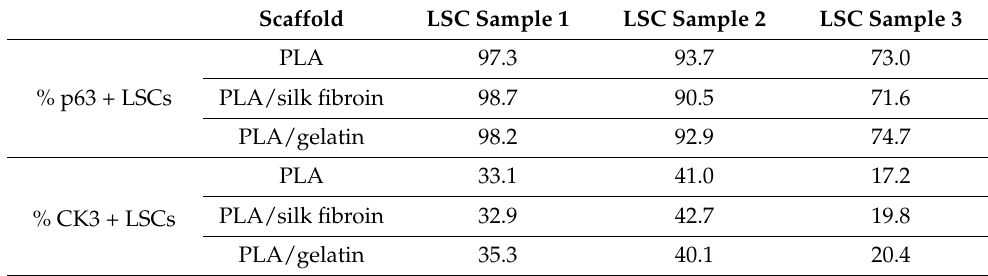
Table 2. Percentages of p63 and CK3 expressions of LSCs grown on PLA and modified PLA scaf- folds.